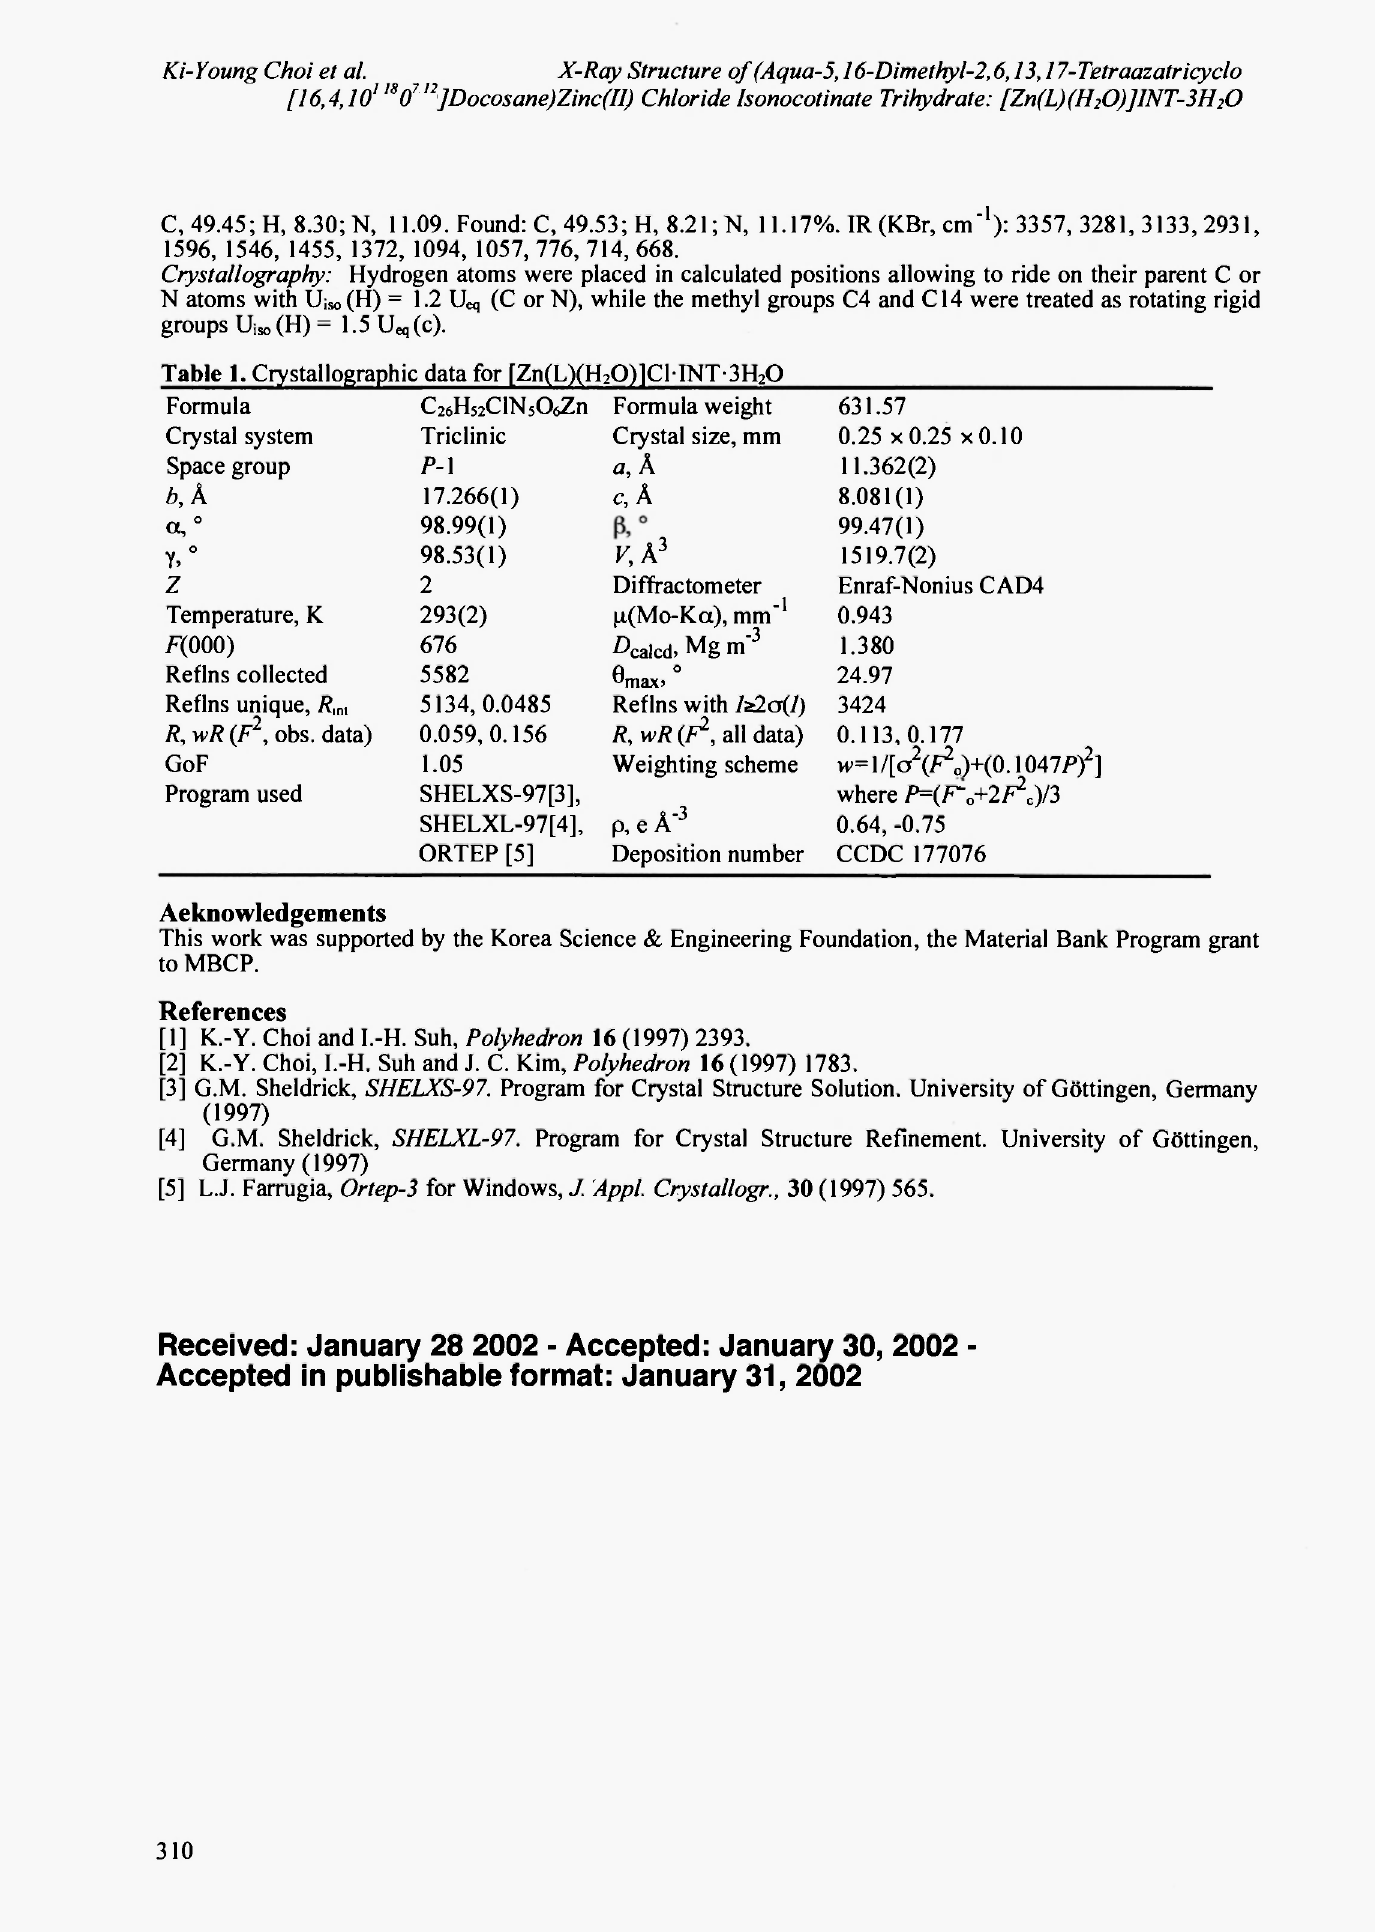
Table 1. Crystallographic data for fZn(L)(H20)lCi rNT-3H